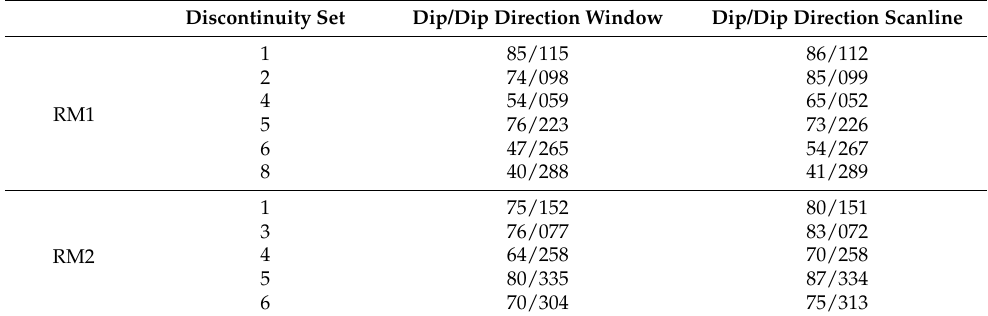
Table 2. List of the discontinuity sets extracted by the scalar field approach through both survey window and scanline; n.a. is reported when the corresponding discontinuity set was not detected.